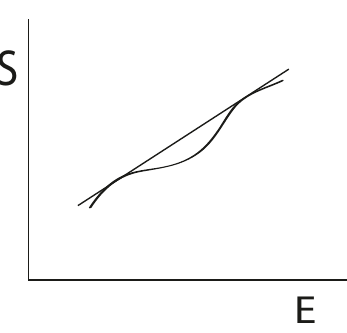
Figure 5 . Entropy versus energy in a (cid:12)rst order transition. The common double slope indicates the temperature where the (cid:12)rst order transition between saddles